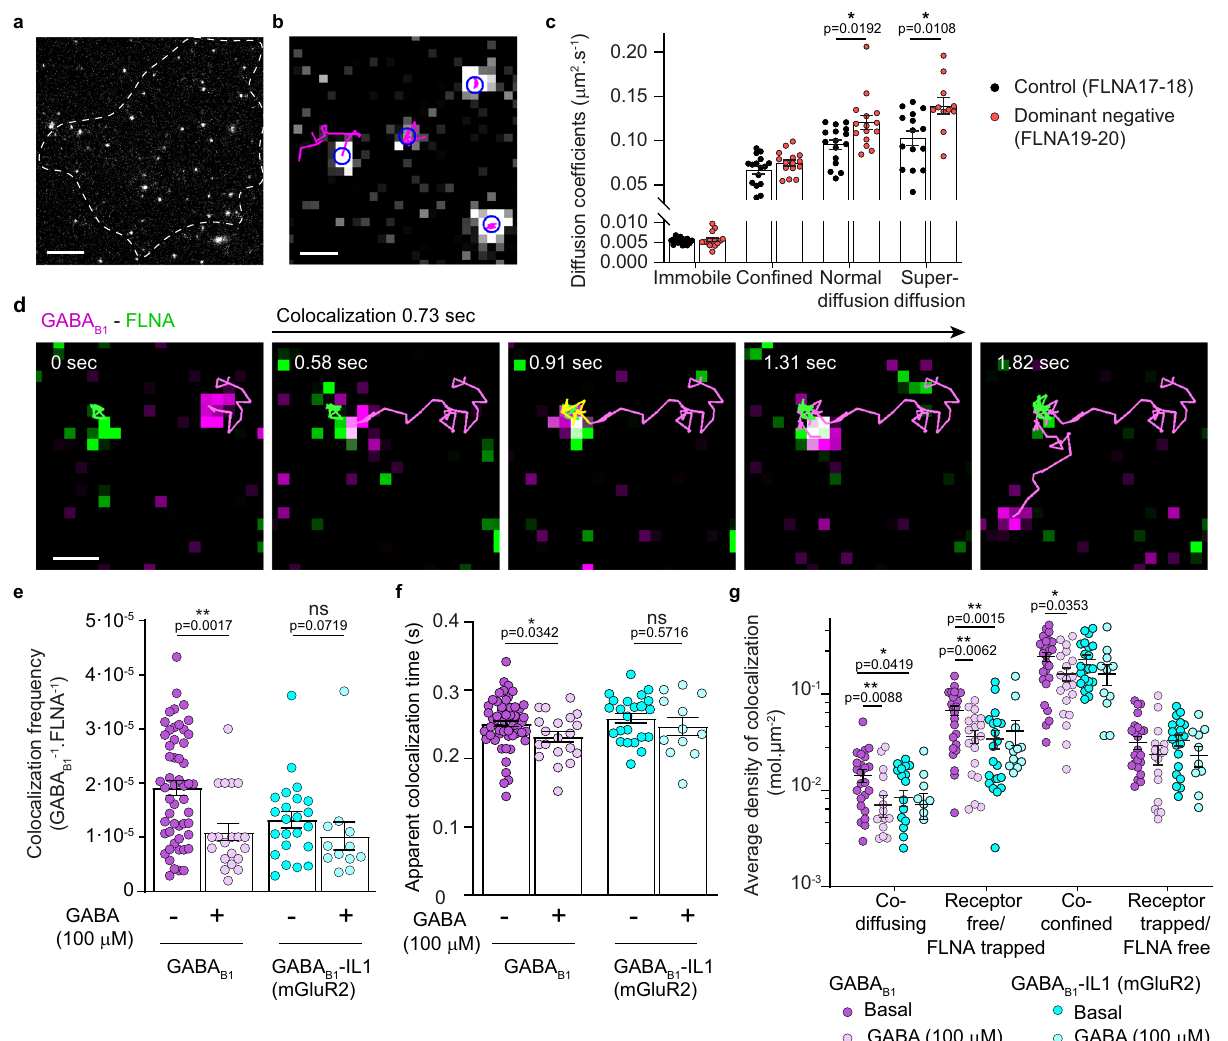
Fig. 4 | FLNA modulates GABA B receptor diffusion at the cell surface. a Representative frame of a single-molecule TIRF image sequenceof SNAP-GABA B1 labeled with SNAP-647 in CHO cells co-transfected with GABA B2 and DsRed- FLNA19-20orDsRed-FLNA17-18asnegativecontrol.Imagesarerepresentativeofat least three independent experiments. b Representative outcome of single-particle tracking from at least three independent experiments. Each detected particle is surrounded by a blue circle and particle trajectories are shown in magenta. c Diffusioncoef fi cientsofGABA B receptorparticlesinthefourgroupsidenti fi edby the TAMSD analysis. Data are mean±SEM from n =16 and 15 cells (2809 and 2670 trajectories) for FLNA17-18 and FLNA19-20, respectively, examined over three independent experiments. d Single-molecule analysis of GABA B -FLNA